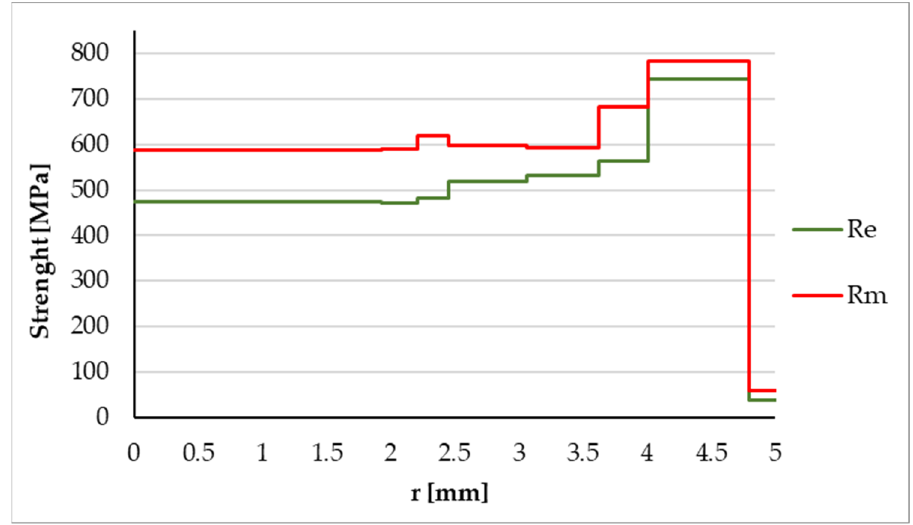
Figure 13. Yield strength and tensile strength of concrete reinforcement ϕ 10—individual layers.